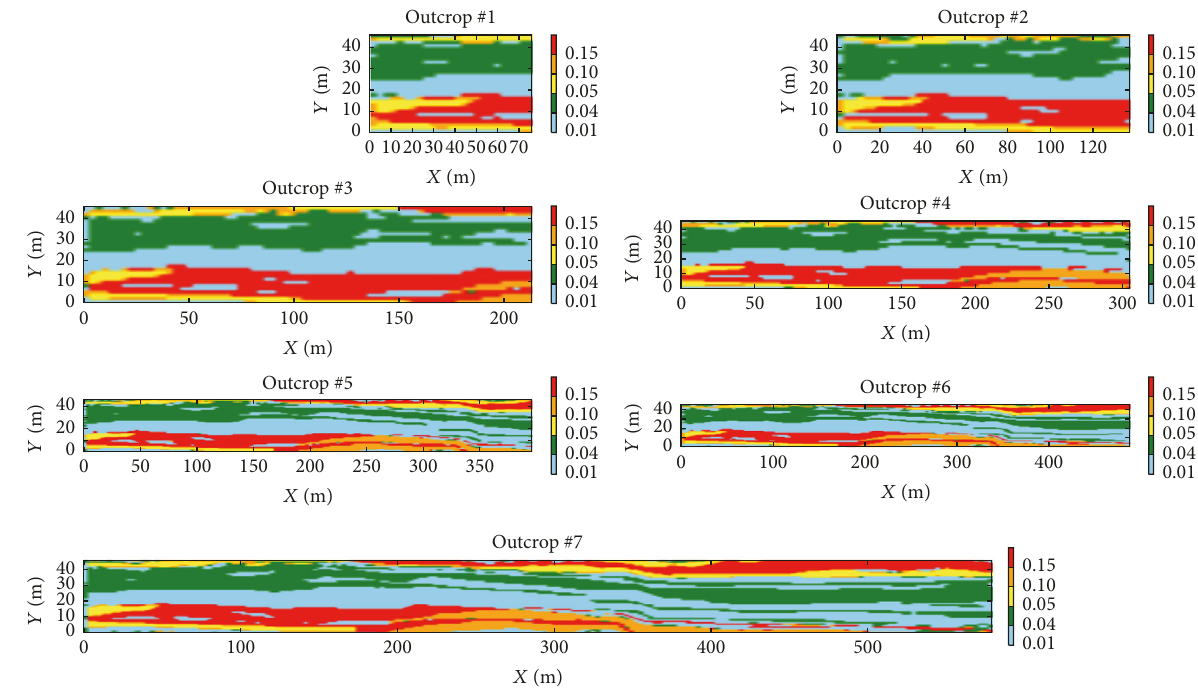
Figure 6: Porosity (fraction) map for seven outcrops at field scale [78,